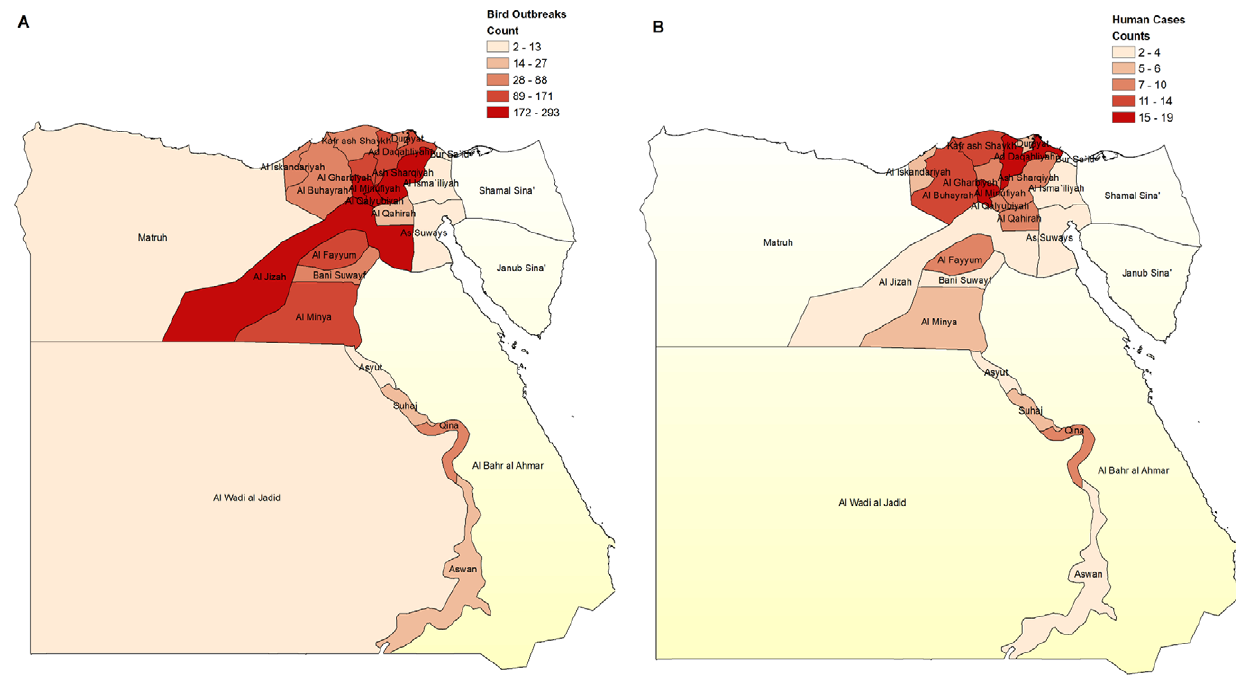
Figure 3. A. Bird outbreaks of H5N1 by governorate 2006–2011. B. Human cases of H5N1 by governorate 2006–2011.